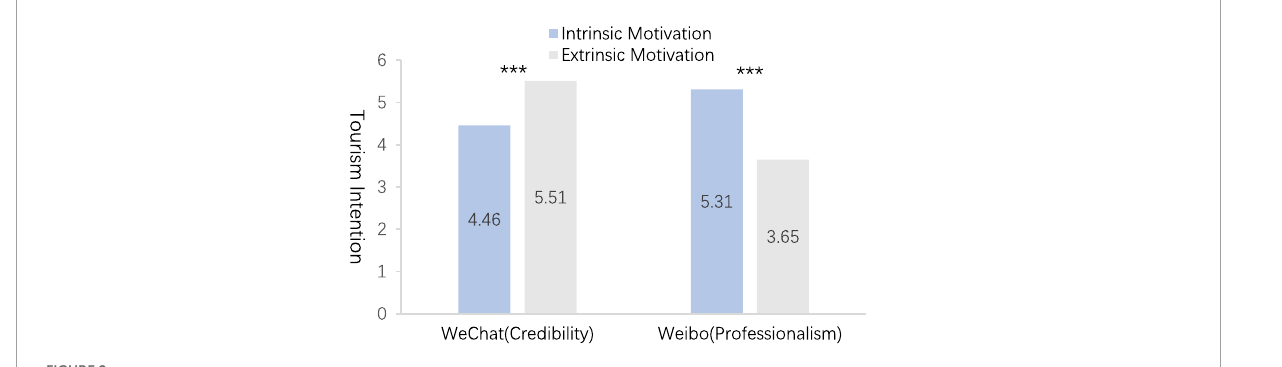
FIGURE2 The influence of potential tourists’ motivation on tourism intention. ∗∗∗ p <